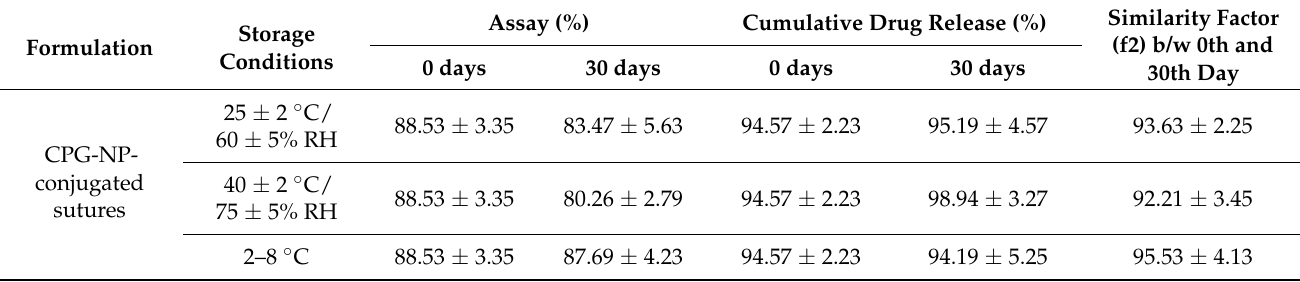
Table 3. Stability study of ciprofloxacin-conjugated gold-nanoparticle-loaded sutures ( n = 3). Data are represented as the mean ±